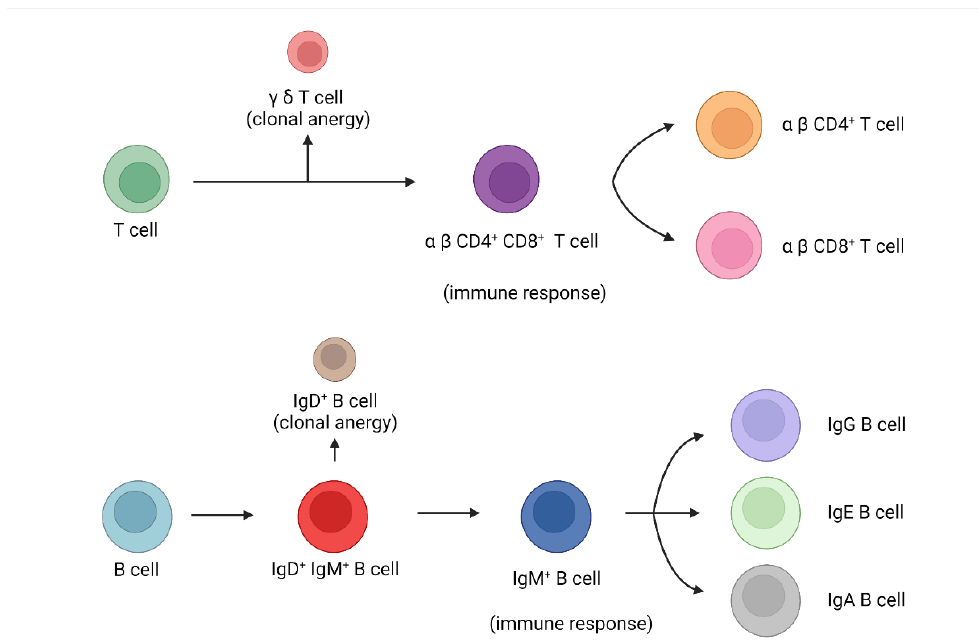
Figure 1. The immune responses and clonal anergy mechanism of B or T cells. If T cells become γδ T cells, they will lead to clonal anergy. If T cells become αβ T cells, they will subsequently become CD4 or CD8 T cells to induce immune reactions. If B cells become IgD B cells, they will lead to clonal anergy. If B cells become IgM B cells, they will subsequently become IgG, IgE, and IgA B cells to induce immune reactions.